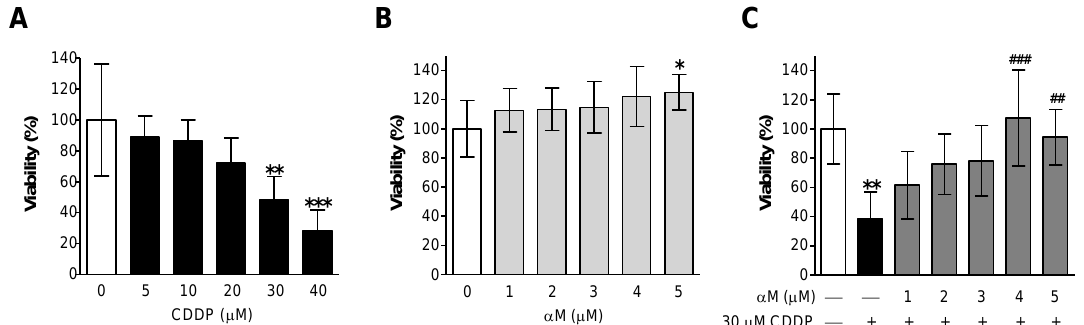
Figure 1. Protective e ff ect of alpha mangostin ( α M) against cis-dichlorodiammineplatinum II (CDDP) induced cell death. Lilly laboratory culture porcine kidney (LLC-PK1) cells were treated with ( A ) 0–40 µ M cisplatin, ( B ) 0–5 µ M α M or ( C ) co incubated with 30 µ M CDDP and increasing concentrations of α M for 24 h. After treatment, cell viability was measured by the fluorescein diacetate (FDA) assay. The data are presented as mean ± SD, n = 5–7. *** p < 0.001, ** p < 0.01 and * p < 0.05 vs. control (0). ### p < 0.001 and ## p < 0.01 vs. CDDP.